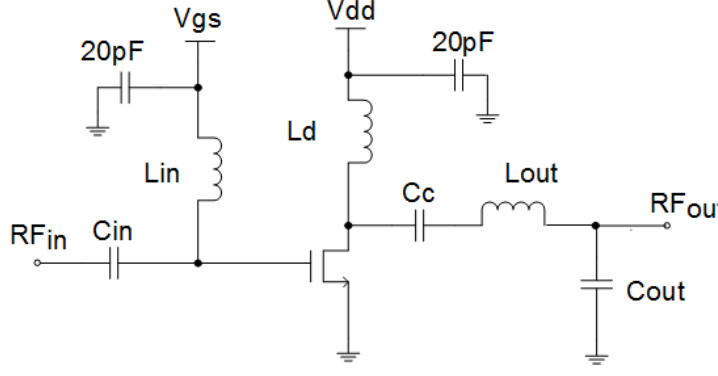
Figure 2. Schematic of a Class AB power